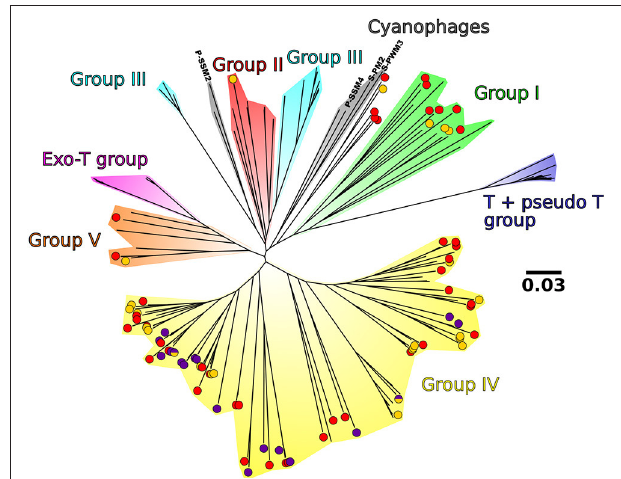
FIGURE 8 | Non-rooted neighbor joining tree of the 85 viral OTUs present in at least 1% in at least 1 sample, 4 cyanophage sequences and the sequences from Filée et al. (2005). The background colors represent the different clades described in Filée et al. (2005). Purple, yellow, and half purple half yellow points represent the OTUs present in Figure 7 that are linked to group V1, group V2, and both groups, respectively. For a higher resolution of analysis, OTUs present between 1 and 2% in at least 1 sample were also shown (in red). Bar scale, 0.03 nucleotide substitution per